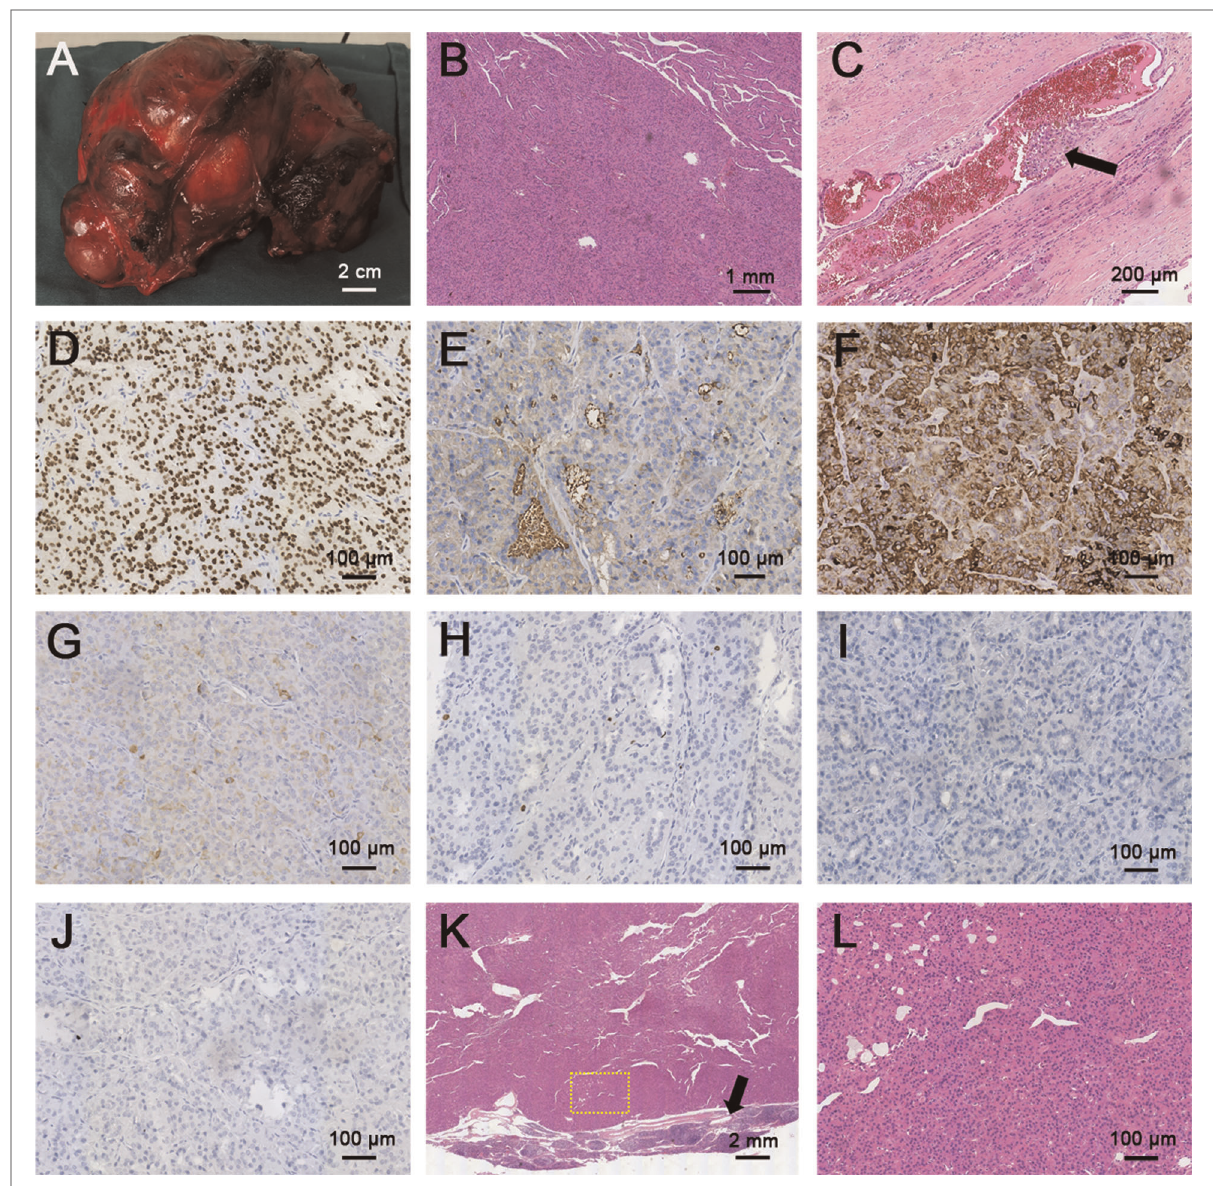
FIGURE 4 Gross and histopathological sections of follicular thyroid carcinoma and metastatic lymph node. ( A ) Gross image of follicular thyroid carcinoma. ( B,C ) H&E staining of follicular thyroid carcinoma ( B , magni fi cation×40), black arrow indicated the vascular invasion of follicular thyroid carcinoma, the thyroid follicular epithelial cells were invaded into the blood vessel ( C , magni fi cation×100). ( D – J ) Immunohistochemical (IHC) staining of follicular thyroid carcinoma (magni fi cation×200) for ( D ) TTF-1, ( E ) TG, ( F ) CK 7, ( G ) CK pan, ( H ) Ki 67, ( I ) calcitonin, ( J ) PTH. TTF-1 and CK7 were deeply stained (positive), TG and CK pan were partially stained (partial positive), Ki67 proliferation index was less than 1%, calcitonin and PTH didn ’ t stain (negative). ( K,L ) H&E staining of neck metastatic lymph node: ( K ) magni fi cation×16, ( L ) magni fi cation×400. Yellow dashed circle indicated the ampli fi cation part in the picture K , black arrow indicated the normal part of the metastatic lymph